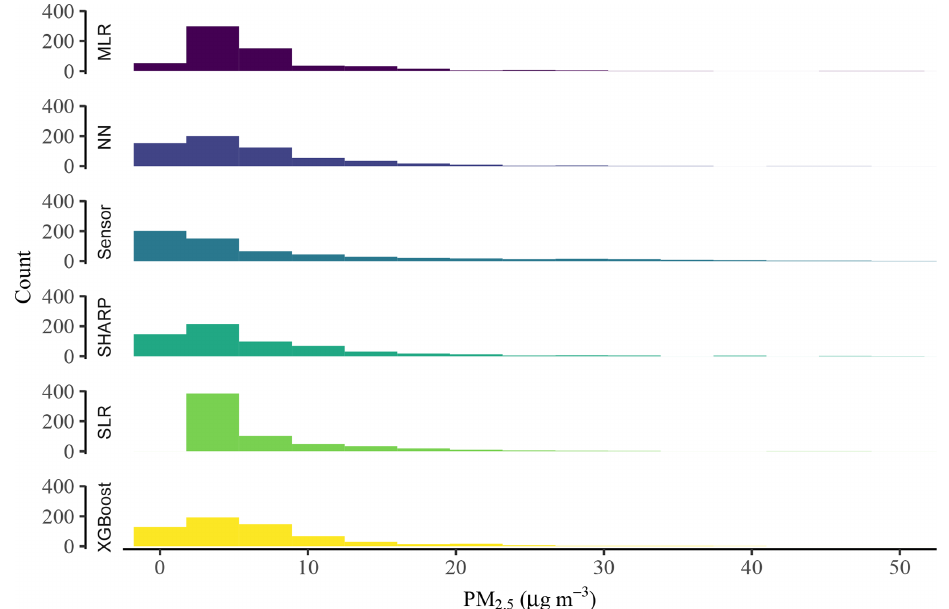
Figure 9. Data distribution comparison. Based on 610 test examples. NN: neural network, MLR: multiple linear regression, SLR: simple linear regression.